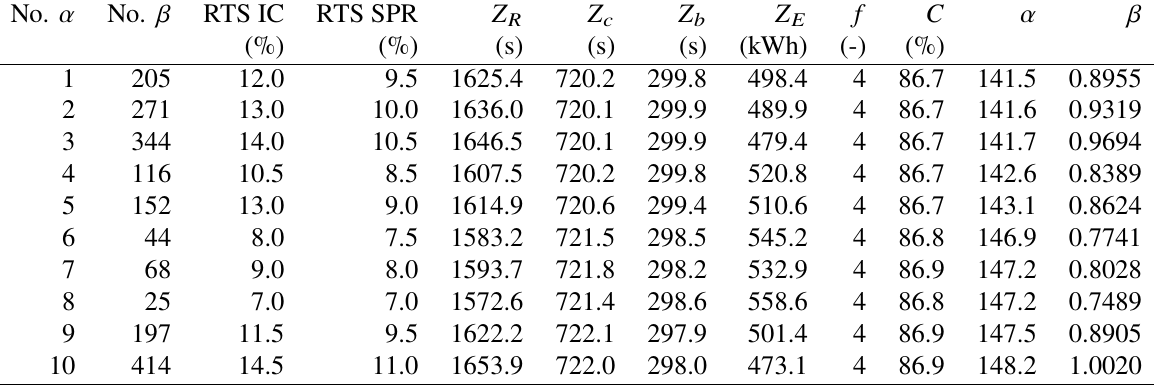
Table 5: First 10 Pareto-optimal solutions with 60 s minimum buffer time considering the objec- tives total running time 𝑍 , extended cycle time 𝑍 , buffer time 𝑍 and energy consumption 𝑍 𝑅 𝑐 𝑏 𝐸 for the real-world case Ah-Nm using the weighted sum method (sorted from low to high accord- ing to 𝛼